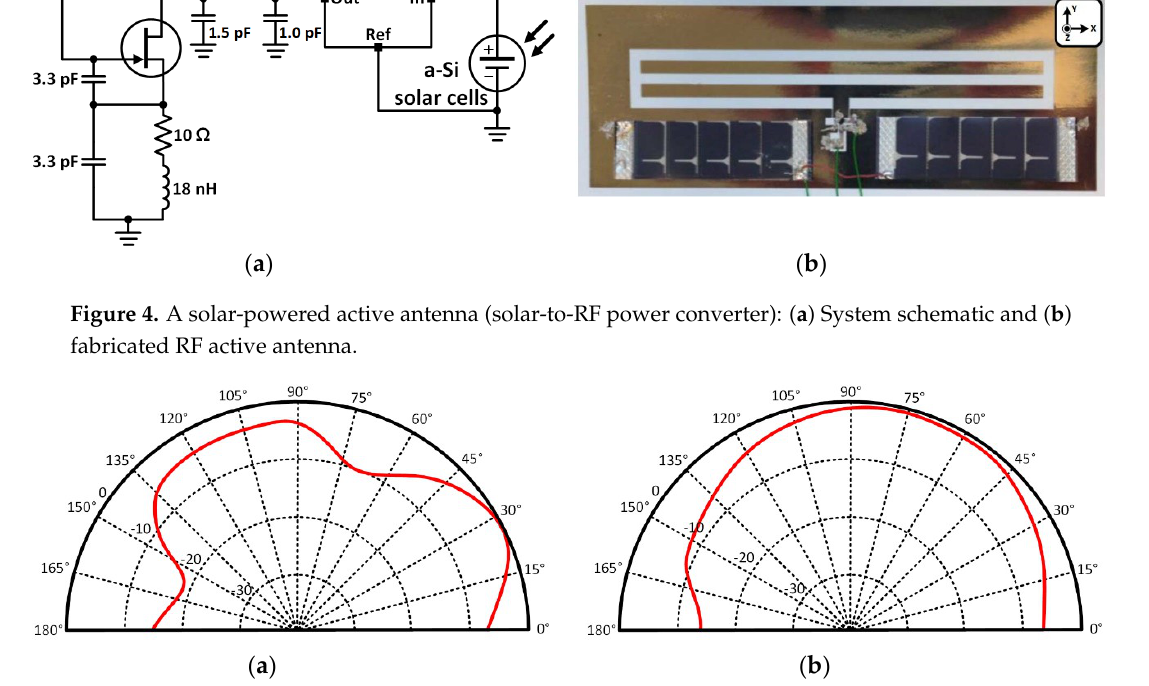
Figure 5. Measured radiation patterns: ( a ) E-plane (xz-plane) and ( b ) H-plane (yz-plane).